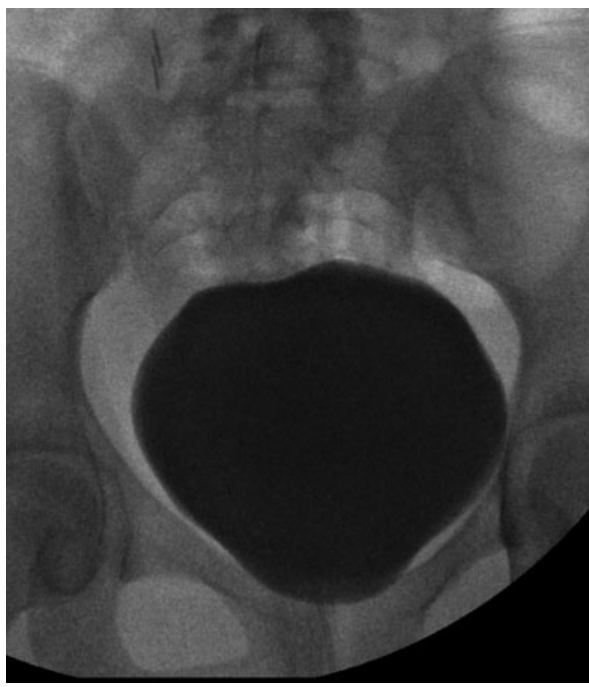
Fig. 1 Normal looking bladder on videourodynamic study. Fig. 2 Wounds after bilateral S3 neurostimulator